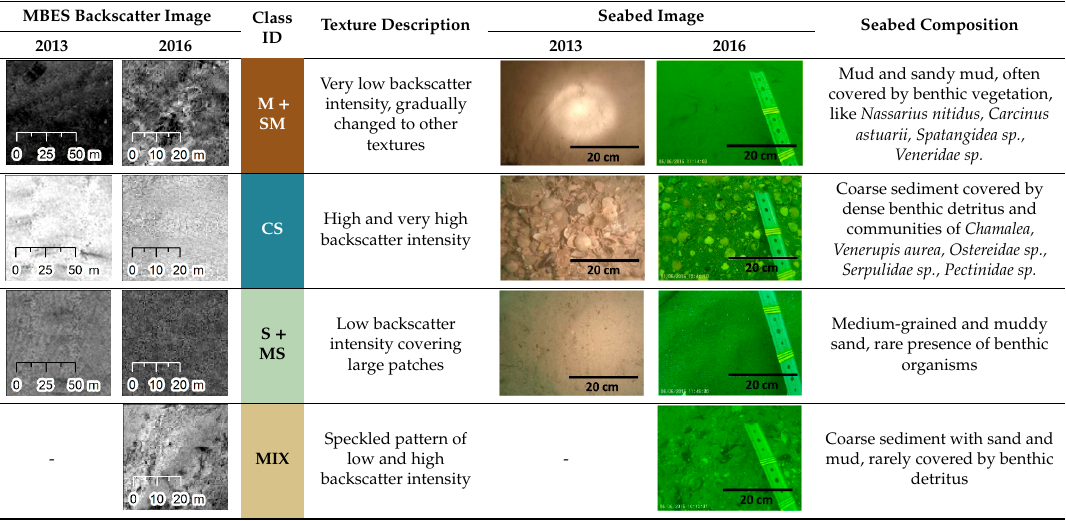
Table 2. Description of the acoustic backscatter of Chioggia 2013 and 2016 areas of interest (AOIs), with corresponding sediment classes and ground truth photographs. CS—coarse sediment; M + SM—mud and sandy mud; S + MS—sand and muddy sand; and MIX—mixed sediment. MBES Backscatter Image